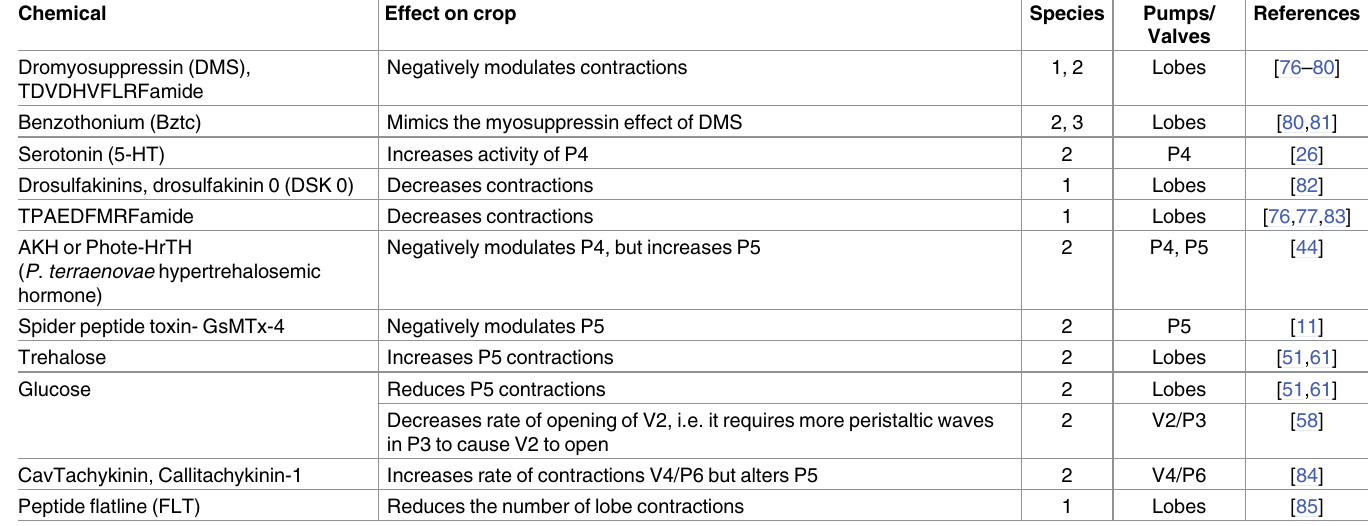
Table 1. Chemicals affecting crop muscle contractions in adult flies. Species: 1- D . melanogaster ; 2- P . regina; 3- M . domestica ;Pumps/Valves based on Thomson [61].